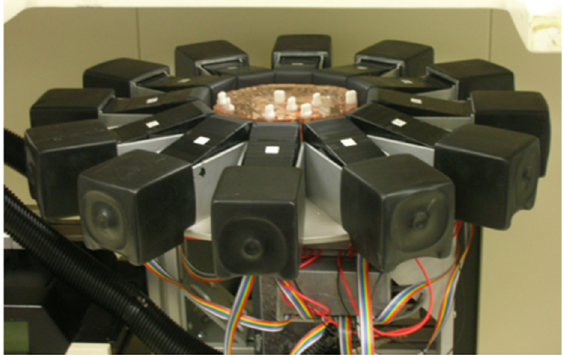
Figure 1. BRPET ring with slanted light guides labeled with white squares. The ring is attached below the breast aperture of a modified Lorad biopsy table.